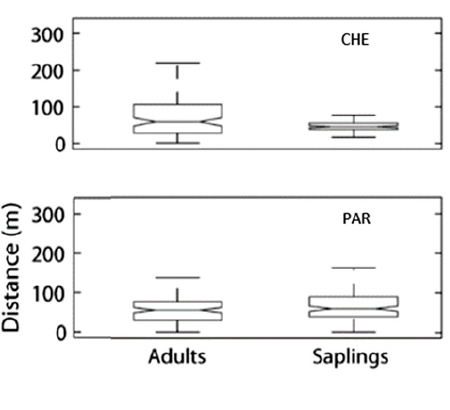
Figure 6. Distribution of distance to streams for adults and saplings at CHE ( top ) and PAR ( bottom ). At CHE adult stems were much more widely distributed with distance from streams whereas saplings were all found within 100 m from a stream. At PAR adults and saplings were similarly distributed with distance from streams though saplings had a greater maximum distance and the median was slightly